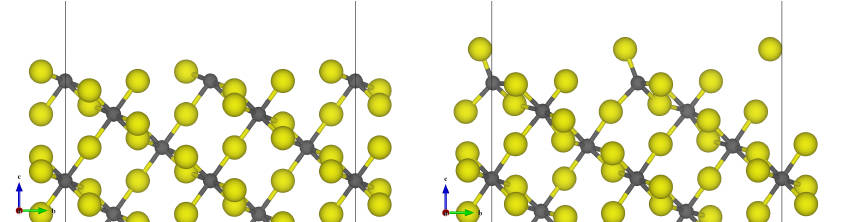
Figure 4. α -AlF 3 - ( 01¯10 ) surface: unrelaxed surface cut of the most stable termination ( left ) and corresponding structurally-optimized surface ( right ). Grey = aluminum, yellow = fluorine. Table 2. Surface energies ( E surf in J m − 2 ) of the pure and chlorine substituted surface, the coordination number (CN) of the aluminum centers at the surface and the reaction energy (kcalmol − 1 ) for that substitution of one chlorine.